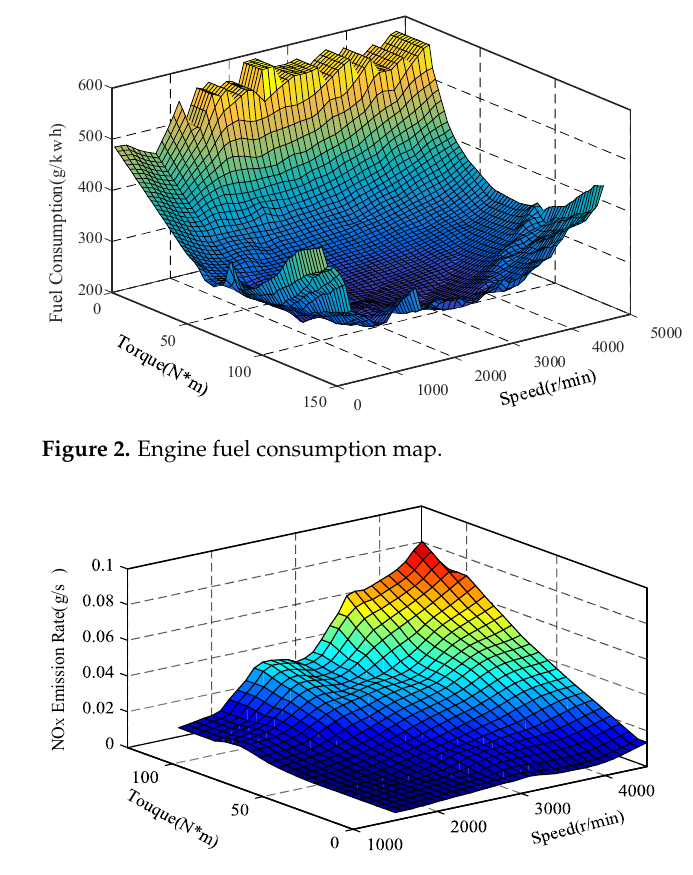
Figure 3. Engine NOX emission Figure 3 . Engine NOX emission map. Figure 3 . Engine NOX emission map.